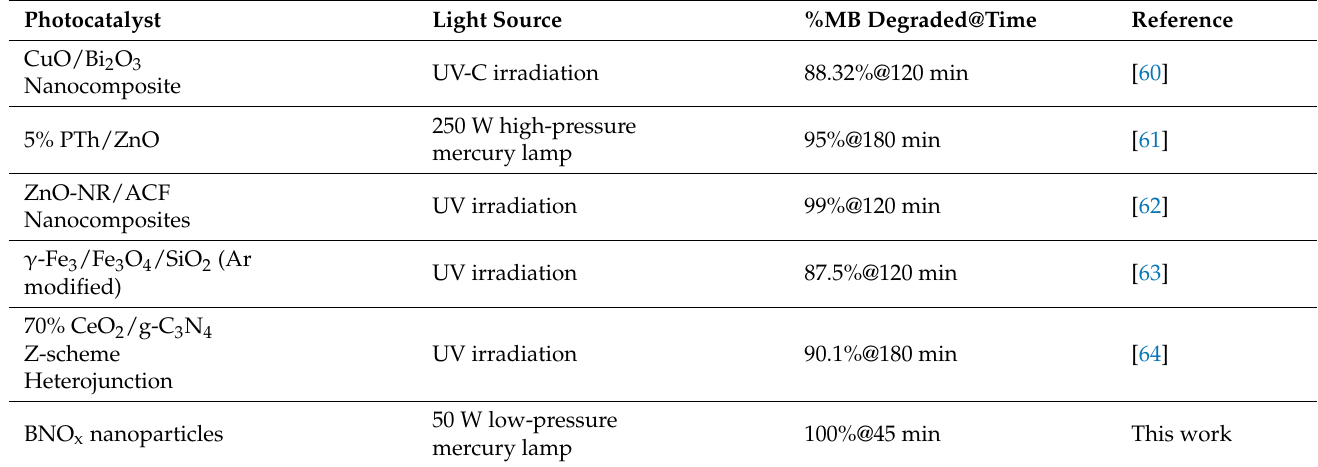
Table 2. Photodegradation of MB over various photocatalysts under UV